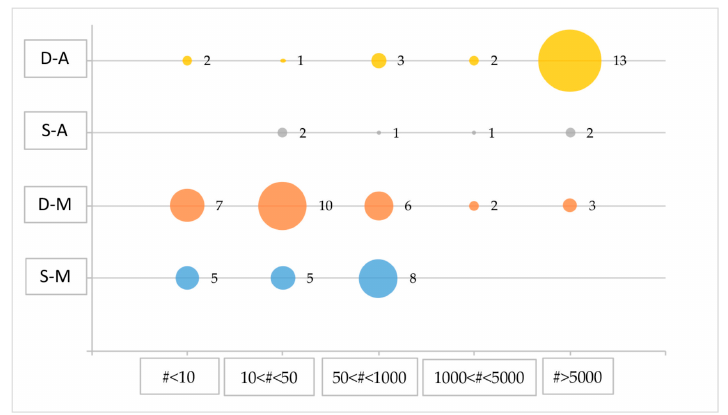
Figure 15. Approach for cost-optimal studies as a function of the number of EEMs packages.